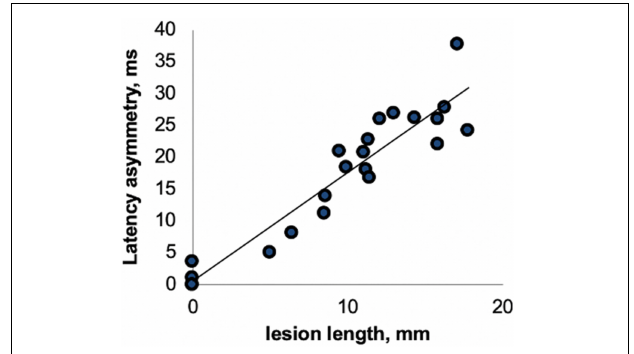
FIGURE 3 | Correlation between optic nerve lesion and mfVEP latency delay [from van der Walt et al.